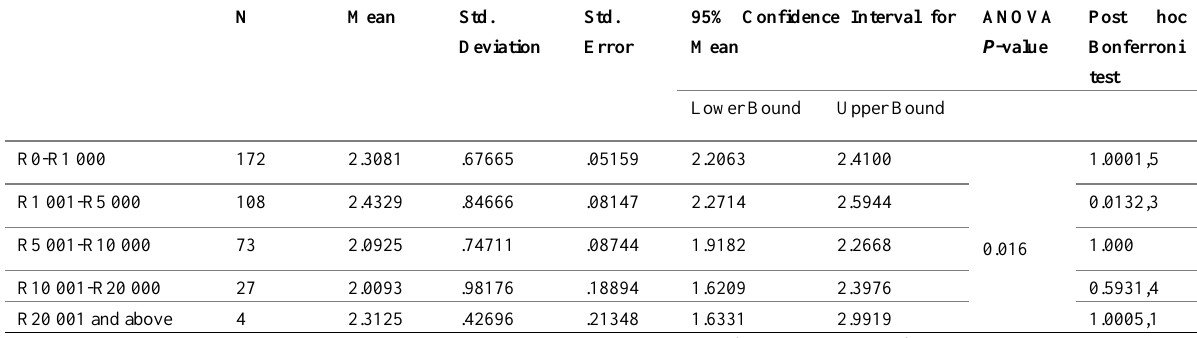
Table 7: Relationship between monthly income and adoption of green